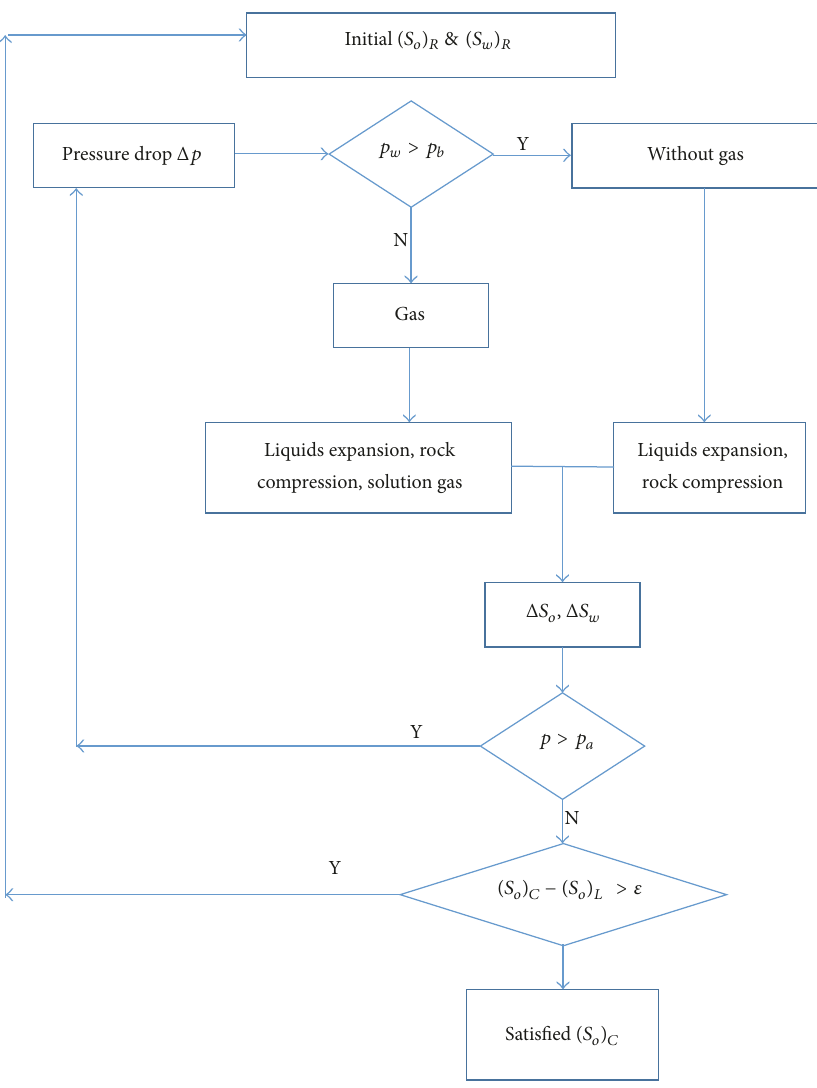
Figure 1: Flowchart of performance matching reservoir